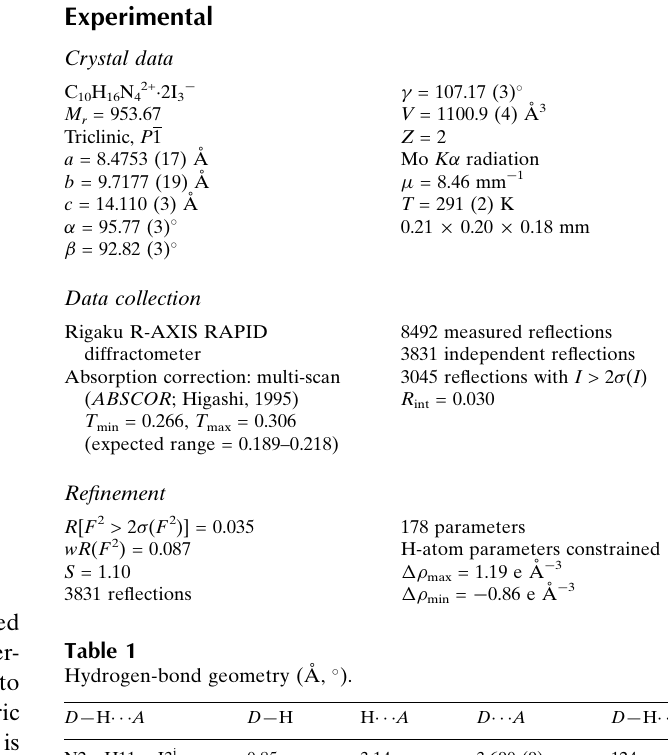
Rigaku R-AXIS RAPID diffractometer